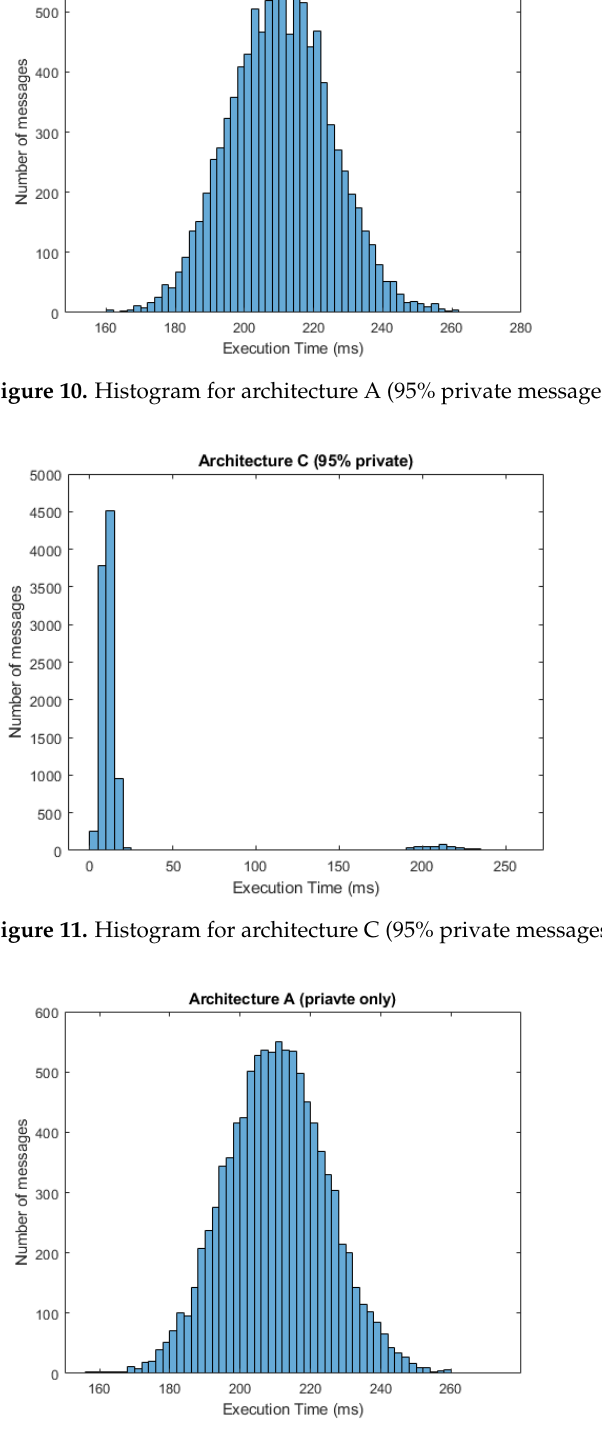
Figure 12. Histogram for architecture A (100% private